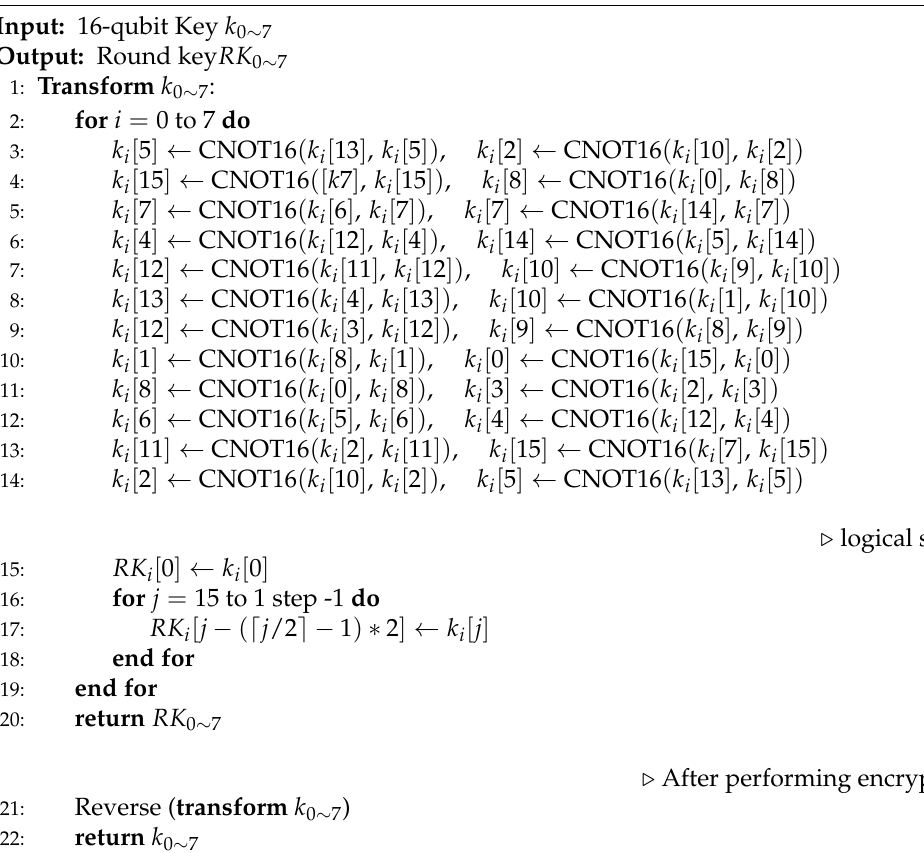
Algorithm 3 Quantum implementation of CHAM-64/128 Key Schedule applying